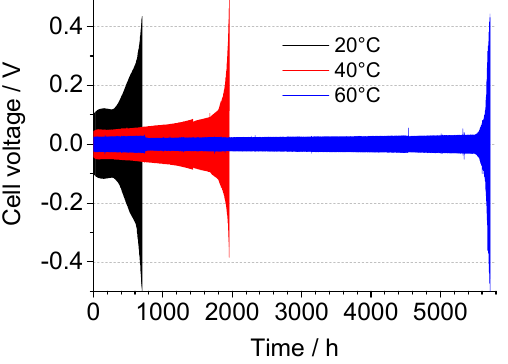
TFSI/Li cells at 14